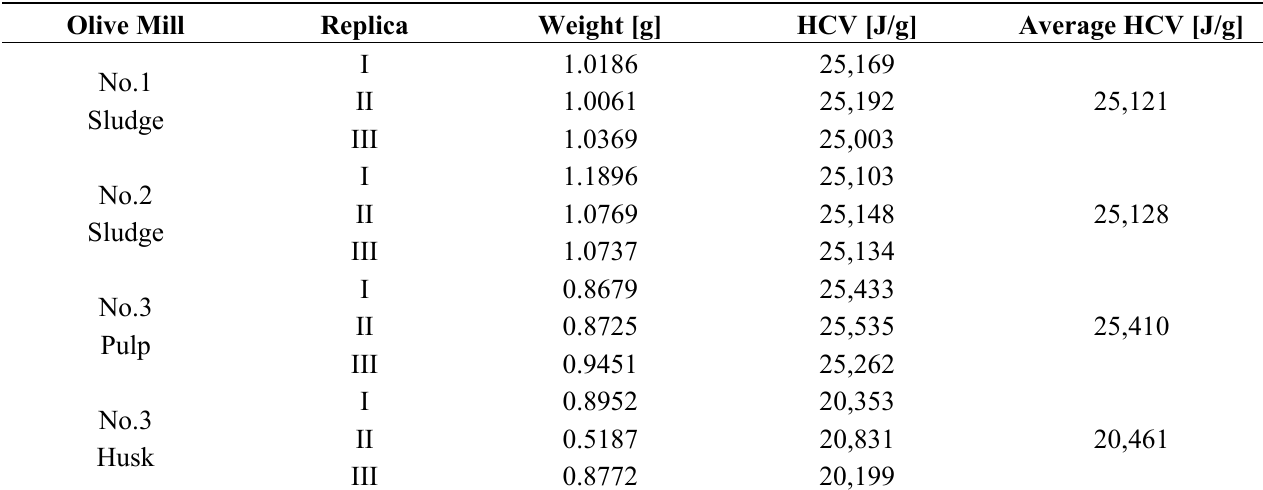
Table 5. Evaluation of HCV.